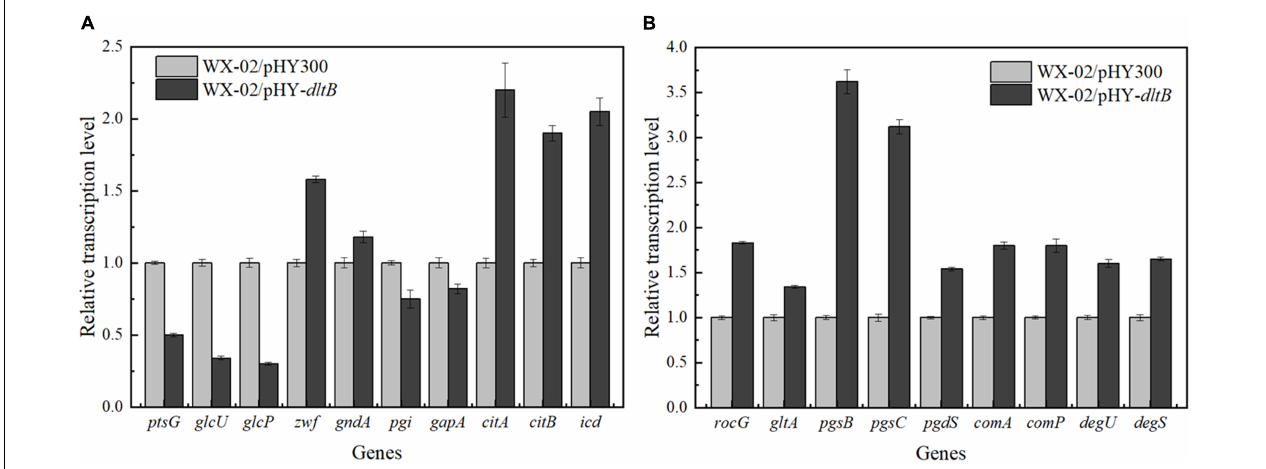
FIGURE 5 | Transcription levels of genes in glucose metabolism and γ -PGA synthesis in WX-02/pHY300 and WX-02/pHY- dltB . (A) Genes in glucose metabolism. (B) Genes in γ -PGA